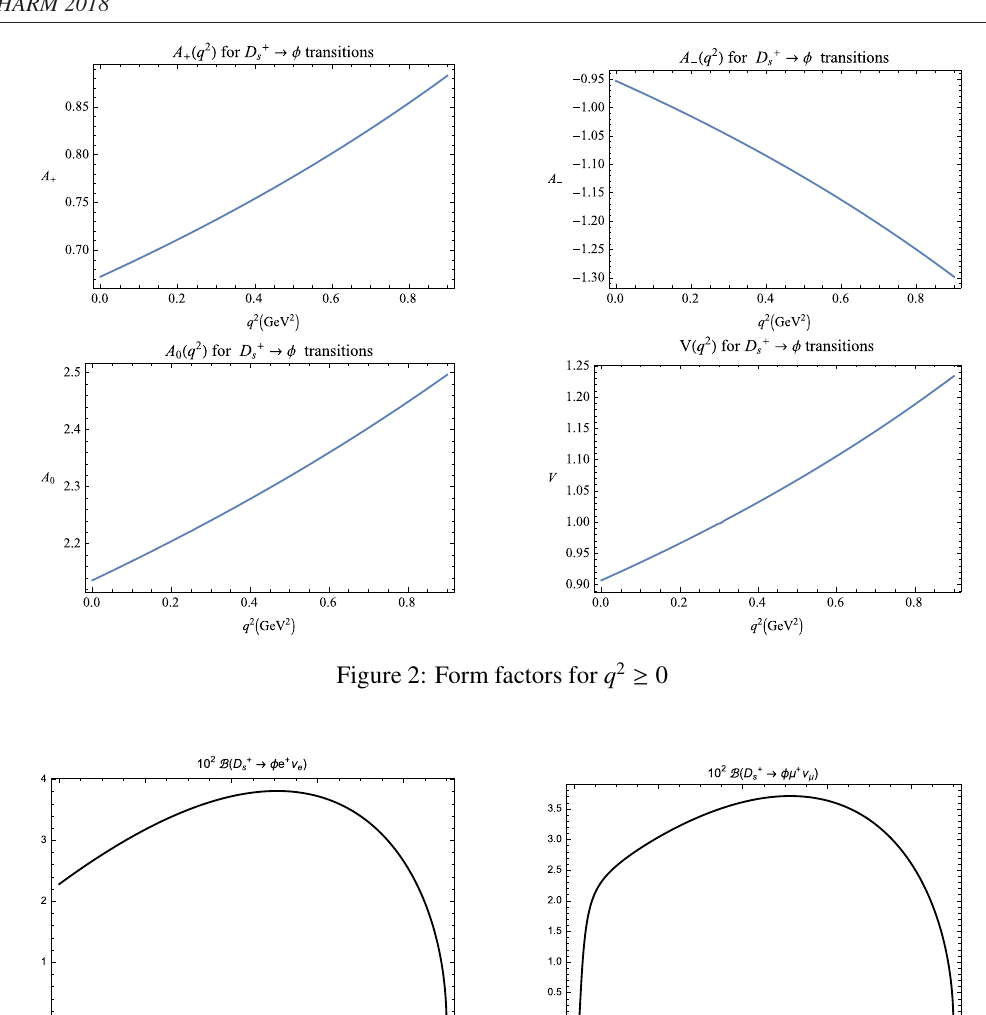
Figure 3: Di ff erential branching fraction for the decays D +